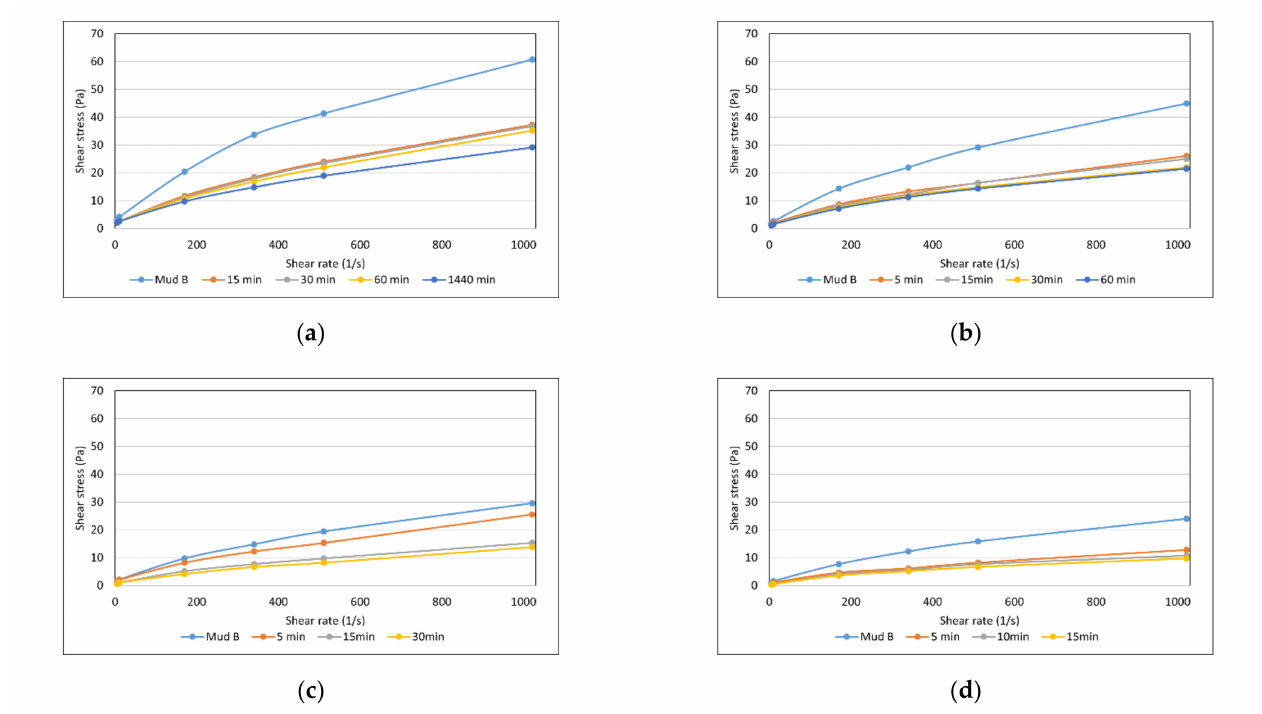
Figure 5. Flow curves of drilling mud B with 1.0% calcium hypochlorite: ( a ) at a temperature of 20 ◦ C, ( b ) at a temperature of 40 ◦ C, ( c ) at a temperature of 60 ◦ C, ( d ) at a temperature of 80 ◦ C.